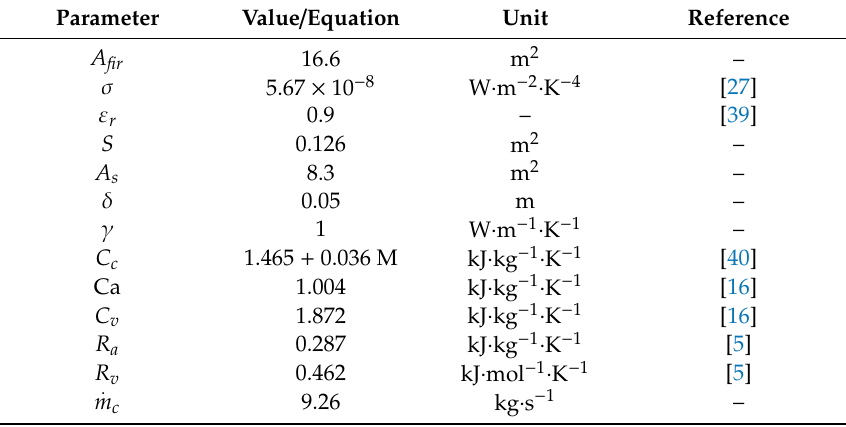
Table 3. Some thermodynamic constants and the related technical